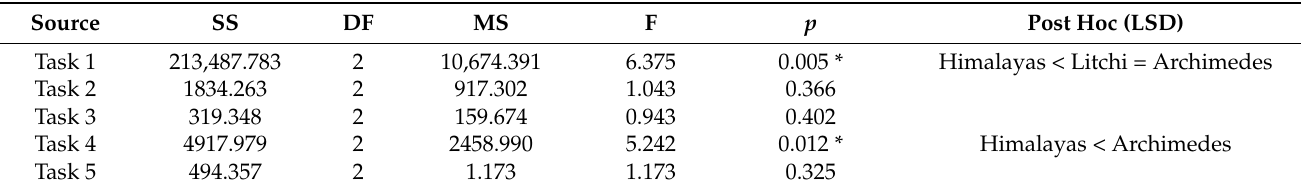
Table 3. The one-way ANOVA result of each task regarding participants’ task completion